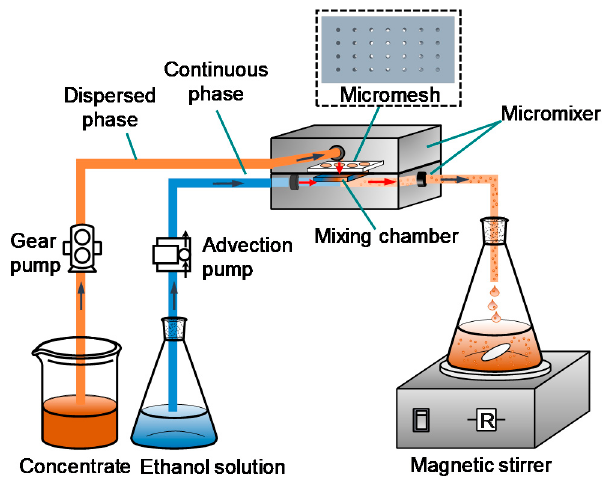
Figure 4. Schematic diagram of the micromesh mixer device.